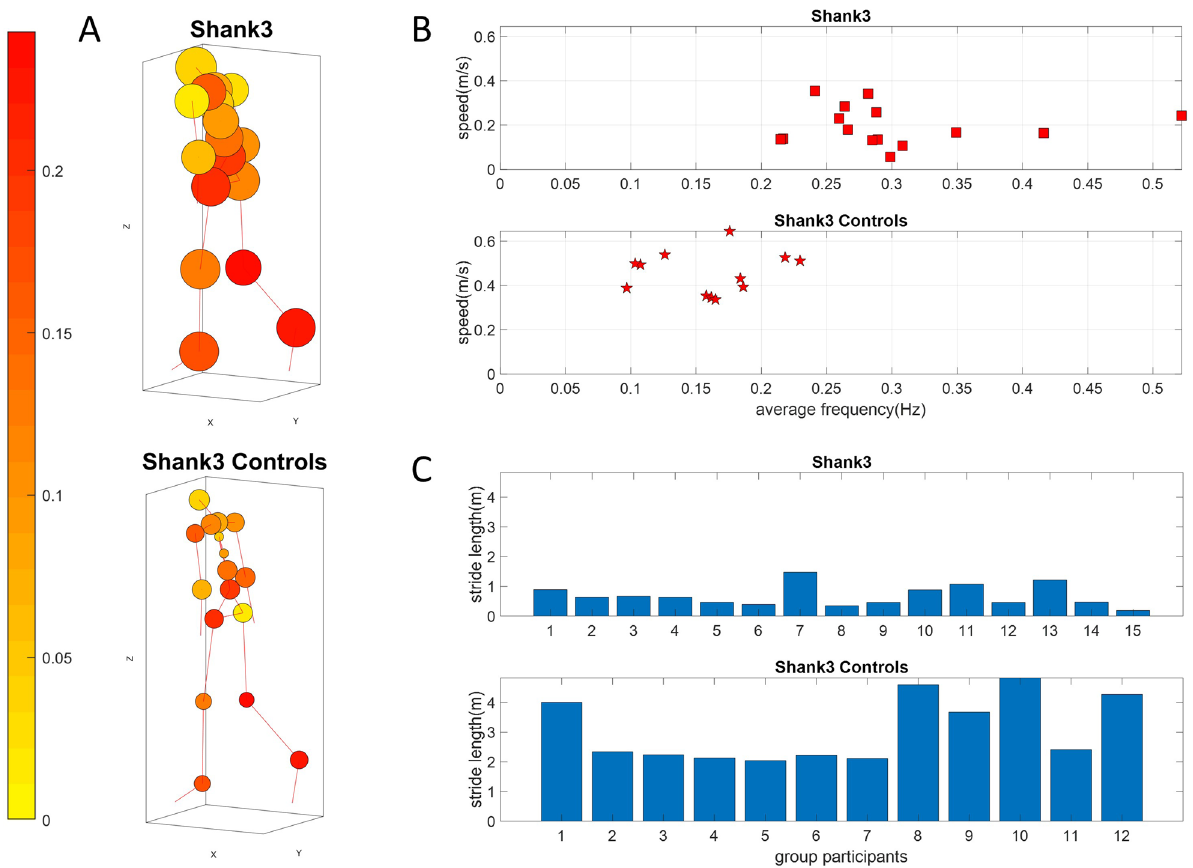
Figure 11. Stride-length differences from speed to frequency ratio obtained from the center of mass trajectories, separate young neurotypical controls from SHANK3-ASD participants. ( A ) Network representation in anthropomorphic avatar form. The size of the nodes is proportional to the maximum coupling frequency (the one that maximizes cross-coherence) of a node with the rest of the body and the color of the nodes is the average time distance (s) between two MMS peaks. ( B ) Parameter space comparing speed vs . frequency. Focusing on the trajectory of the center of mass of the lower body, mean speed over mean frequency of the speed time series has a positive upward trend for healthy controls. This contrasts to a slight negative trend in SHANK3. ( C ) Visible and consistent differences in stride length with SHANK3 deletion participants showing an abnormally small stride length in relation to age- and sex-matched